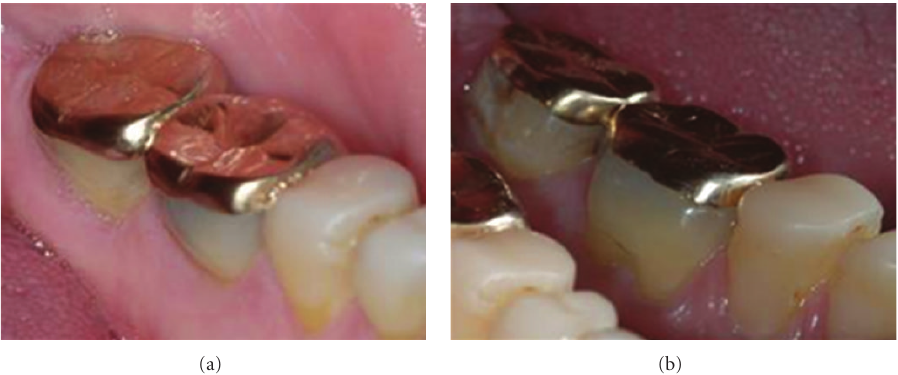
Figure 9: Management of posterior TW using adhesively retained gold onlays at 15 years after